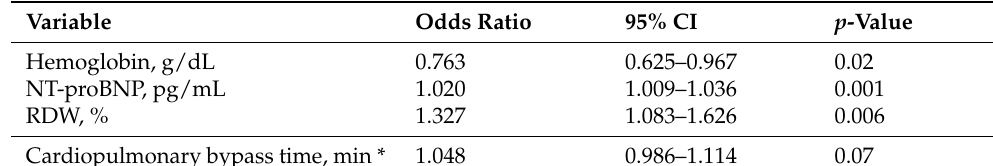
Table 2. Univariate analysis of the predictive factors for the primary